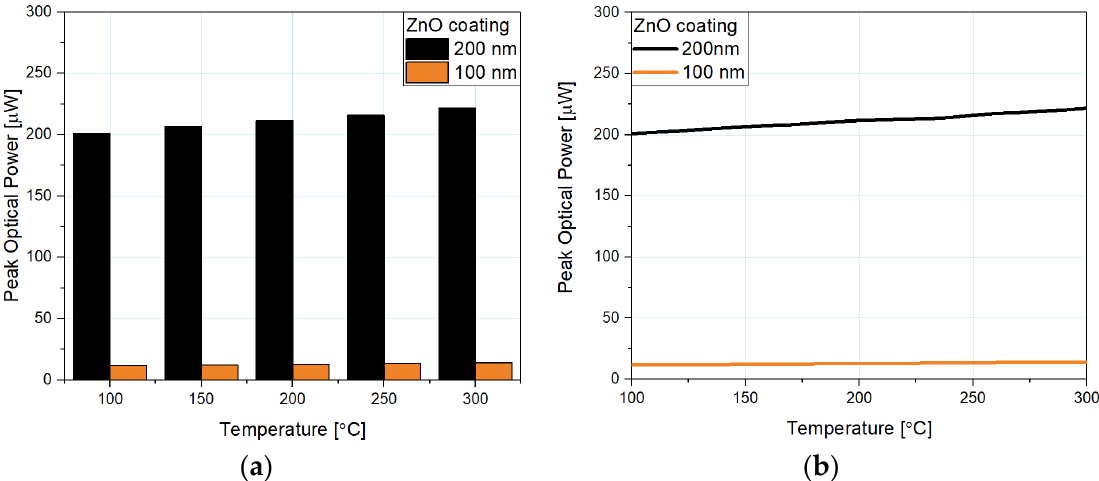
Figure 8. Normalized reflected spectra measured at 100 °C with microsphere-based sensors with a 200 nm (black line) and a 100 nm (orange line) ZnO ALD coating.